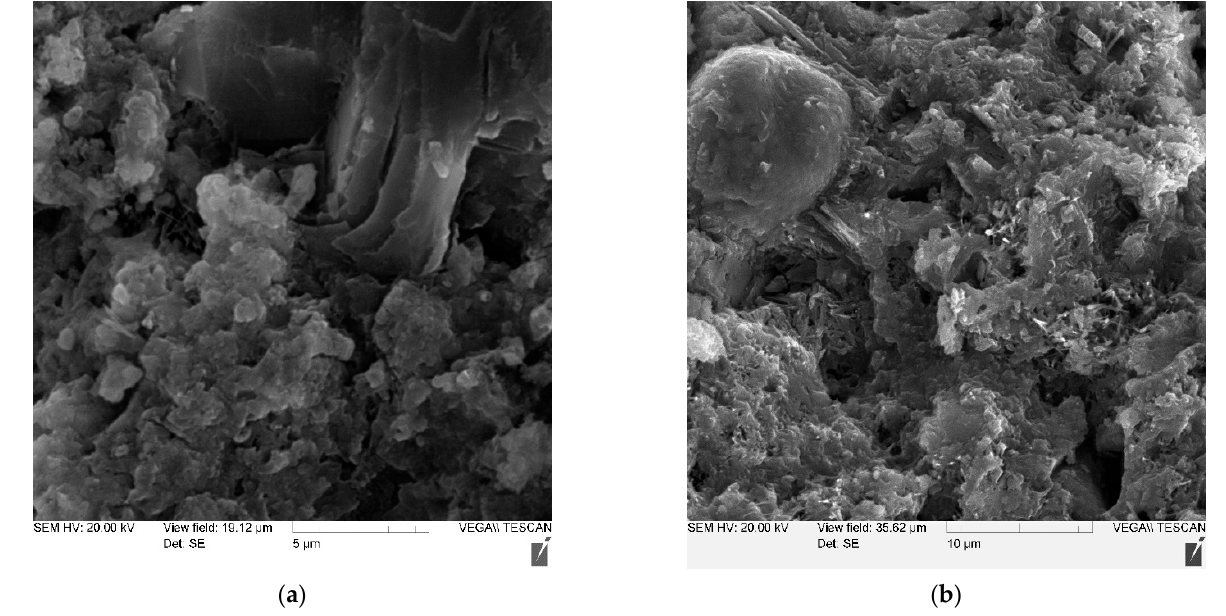
Figure 8. Photo of the microstructure of a cement stone without additives: ( a ) with 2000× magnification ( b ) with 1000× magnification.